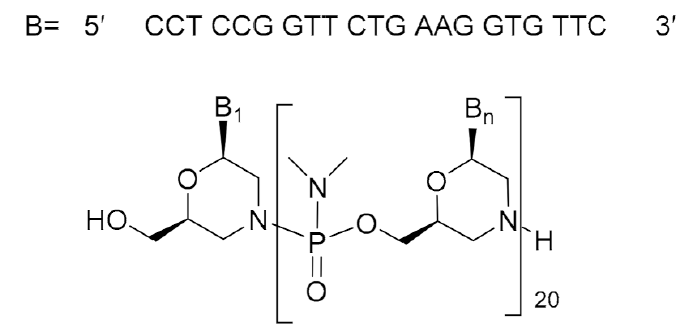
Figure 7. Structure of